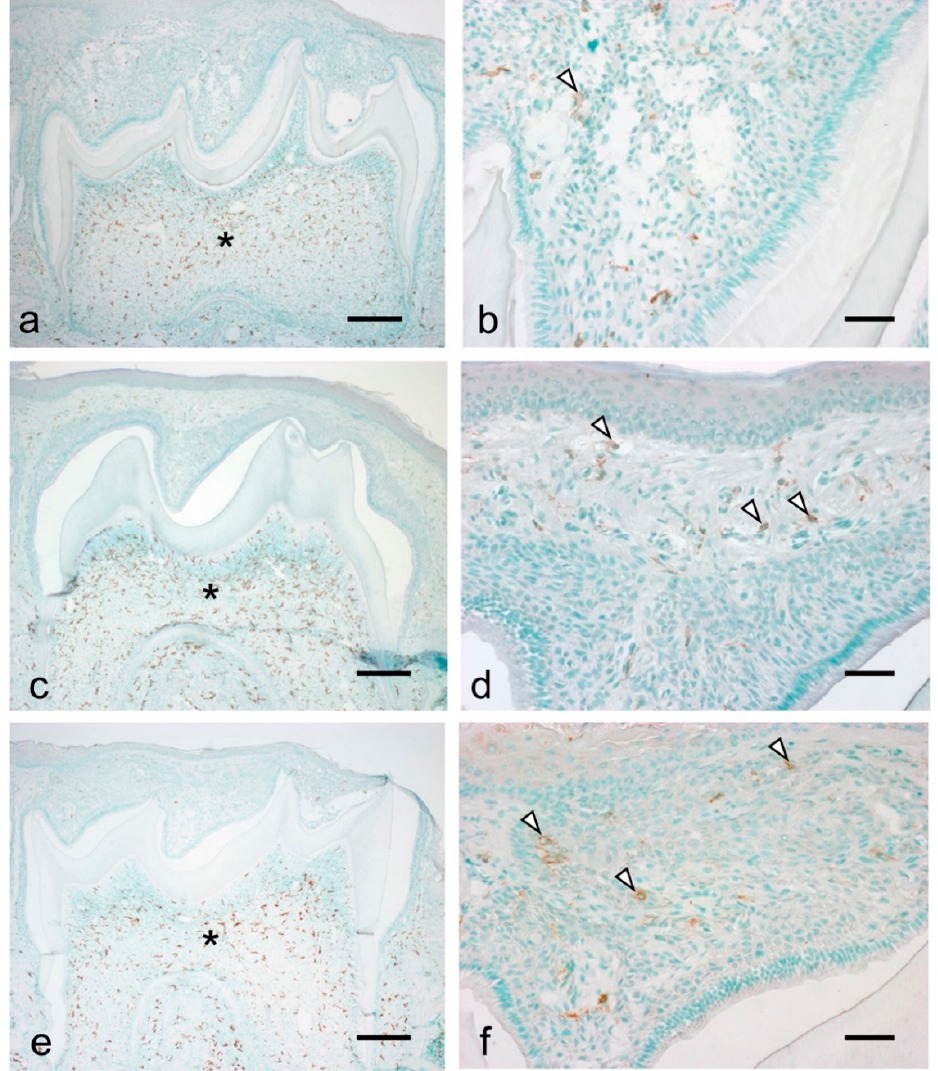
Figure 4. Localization of macrophages during the tooth eruption at 7 dPN ( a , b ), 14 dPN ( c , d ), and 19 dPN ( e , f ). Many residential macrophages were detected in the dental pulp in all stages (asterisks). From 14 dPN, macrophages were easily detected in the connective tissue overlying the tooth organ ( d , f , arrowheads). Bars = 200 μ m in ( a , c , e ); 50 μ m in ( b , d , f ).